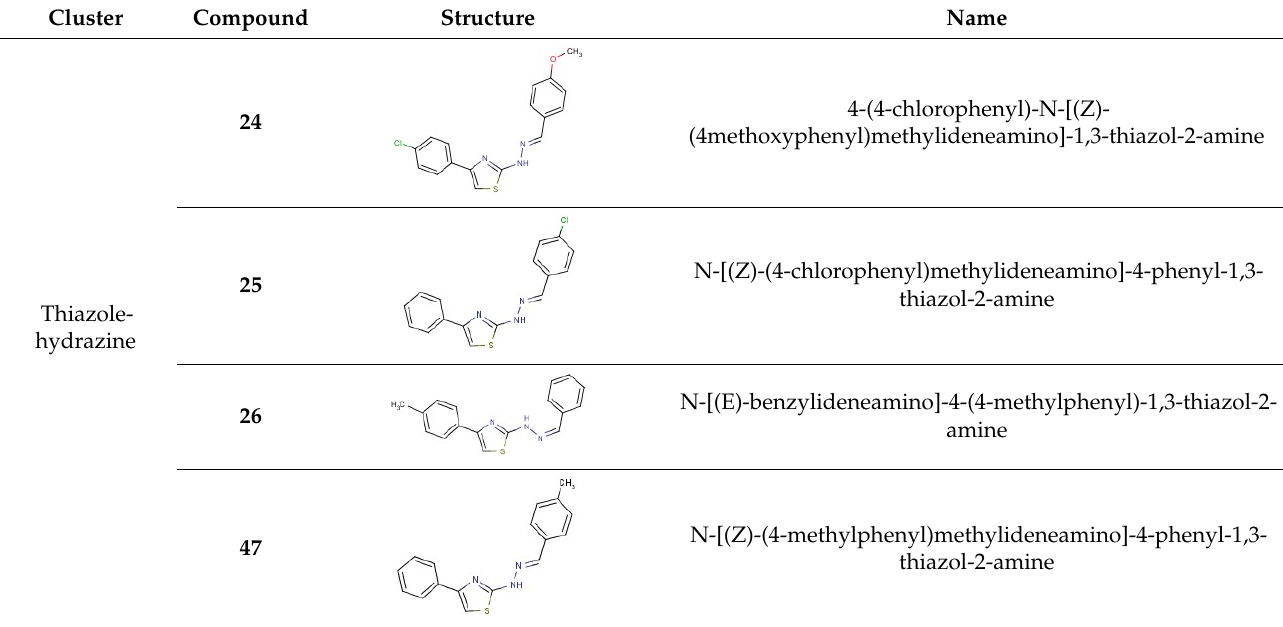
Table 1. The list of active compounds identified in this study. Cluster Compound